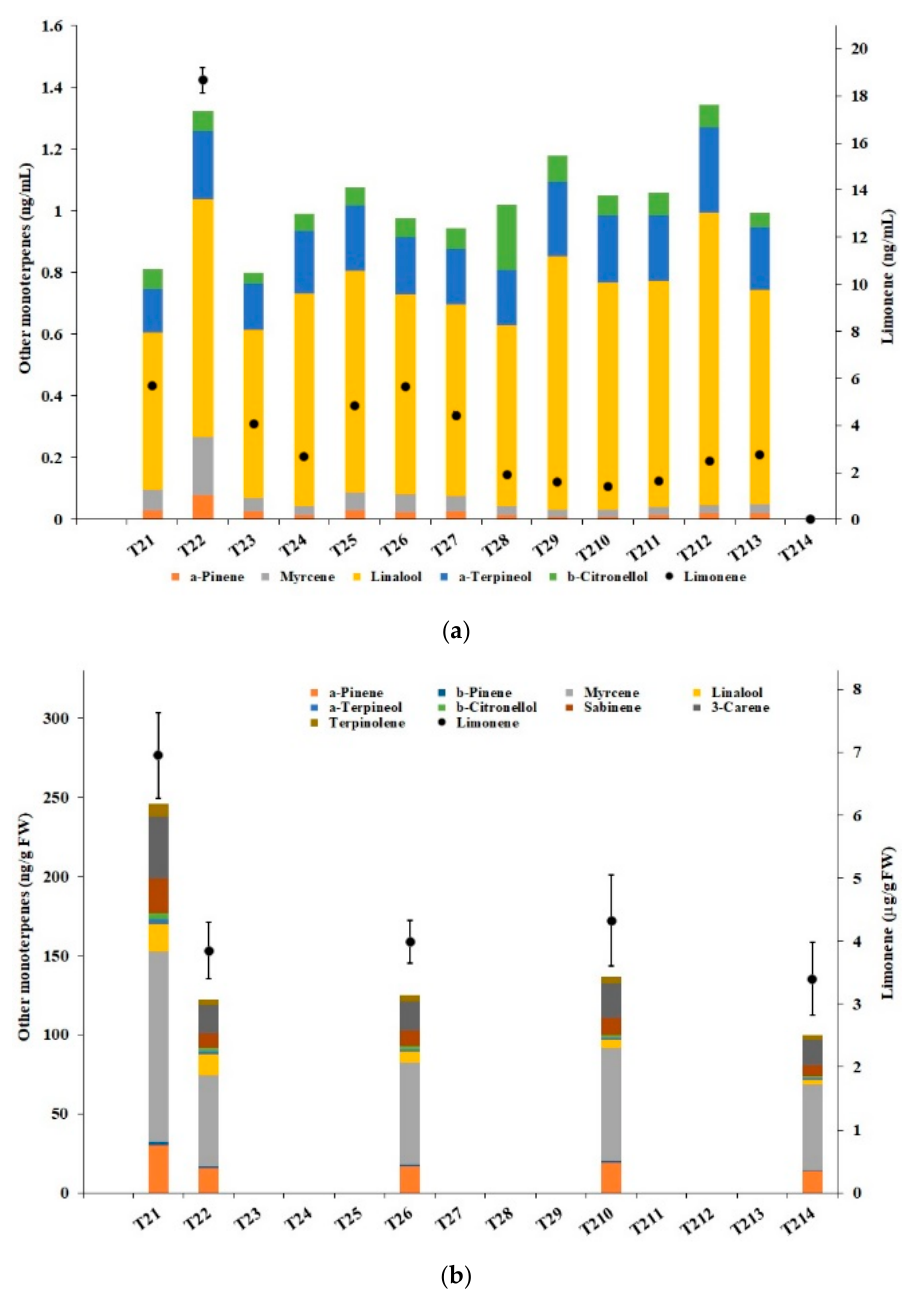
Figure 9. Concentration of monoterpenes: ( a ) Aqueous phase; ( b ) solid residues.